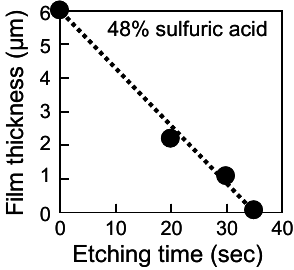
Figure 7. Decrease of film thickness by etching-back using sulfuric acid.